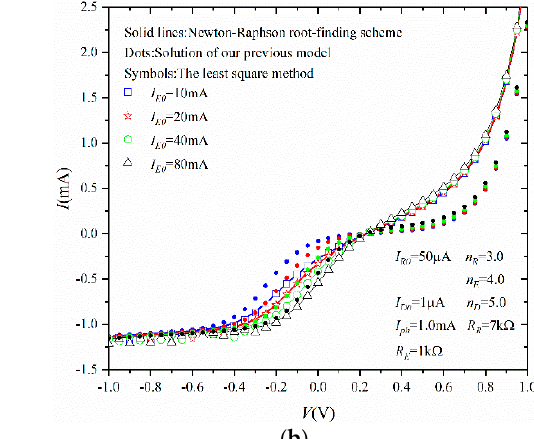
( b ) Figure 6. ( a ) V int ( V ) and ( b ) I ( V ) of the circuit in Figure 2 for different I R 0 .